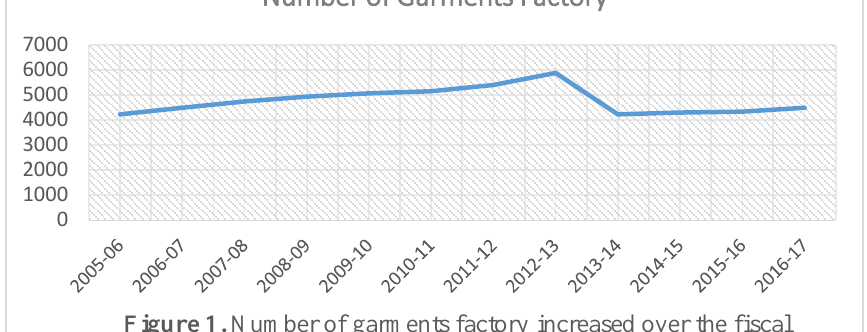
Figure 1. Number of garments factory increased over the fiscal year.